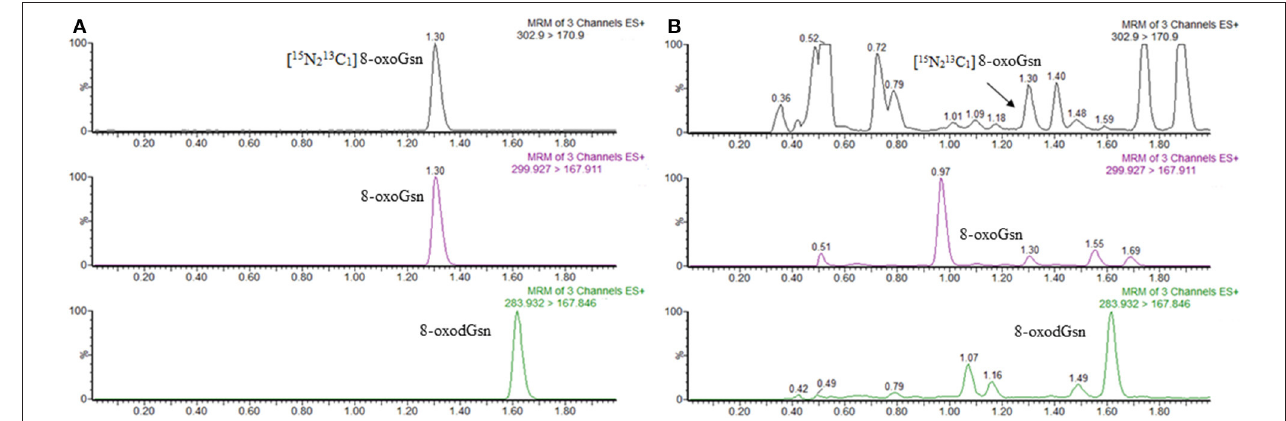
FIGURE 1 | UPLC-MS/MS chromatograms of 8-oxoGsn and 8-oxodGsn. (A) Chromatograms of 8-oxoGsn and 8-oxodGsn standard. (B) Chromatograms of a urine sample.